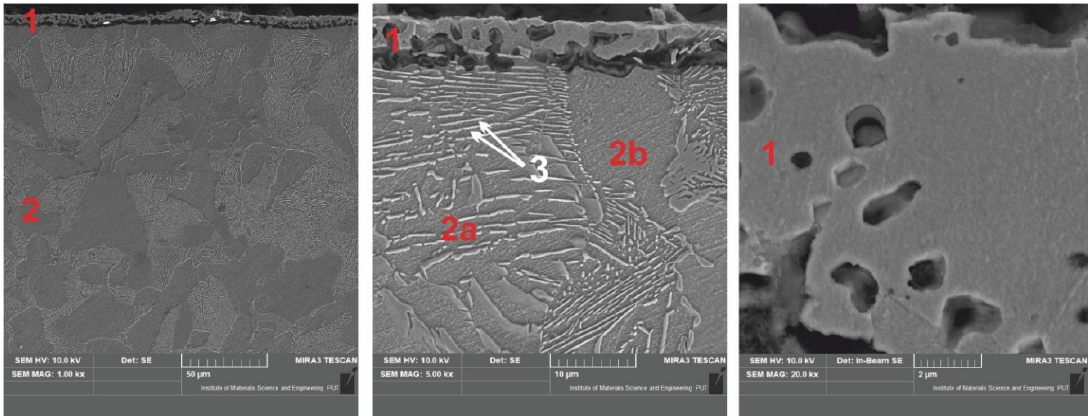
Figure 5. SEM images of gas borocarburized Armco iron in N 2 –H 2 –B(CH 3 O) 3 atmosphere at 1223 K (950 °C) for 2 h; 1—iron borides zone, 2—carburized zone, 2a—pearlite, 2b—ferrite, 3—alternate lamellas of ferrite and cementite in pearlite.